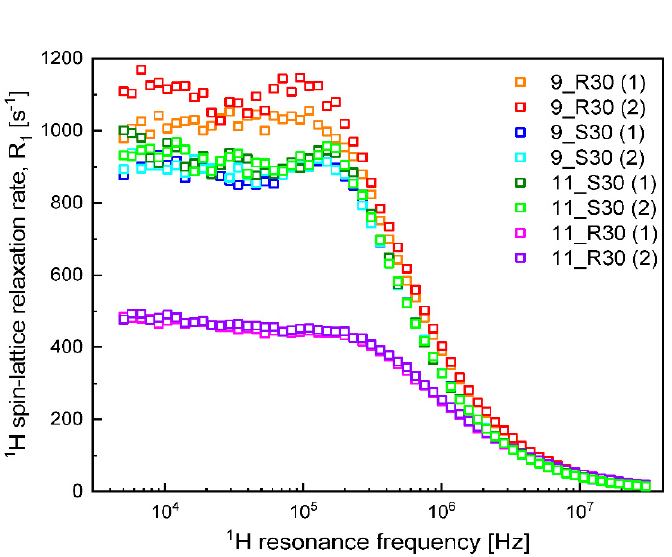
Figure 1. 1 H spin-lattice relaxation data for the prepared samples.